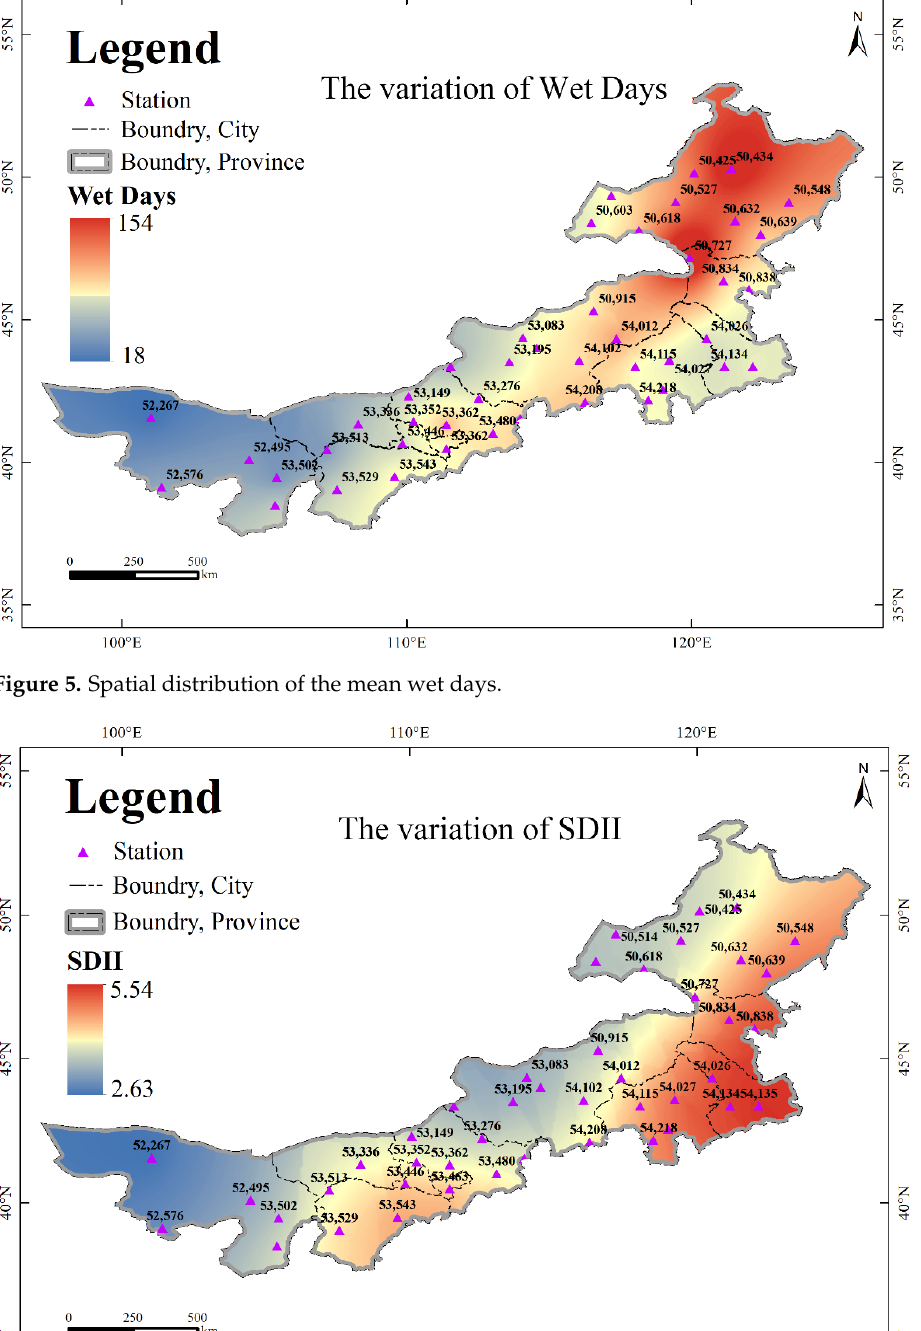
Table 2. Descriptive statistics of the study variables.